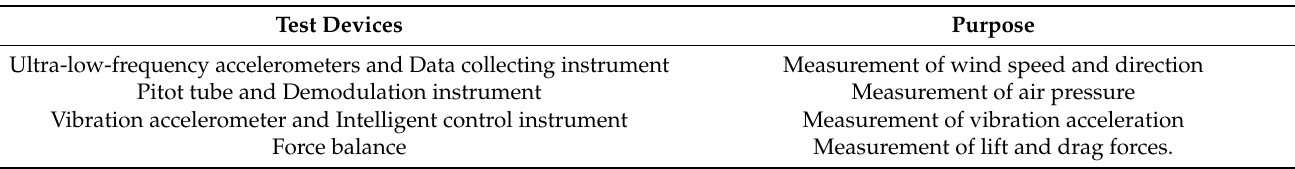
Table 1. Description of the transiting test